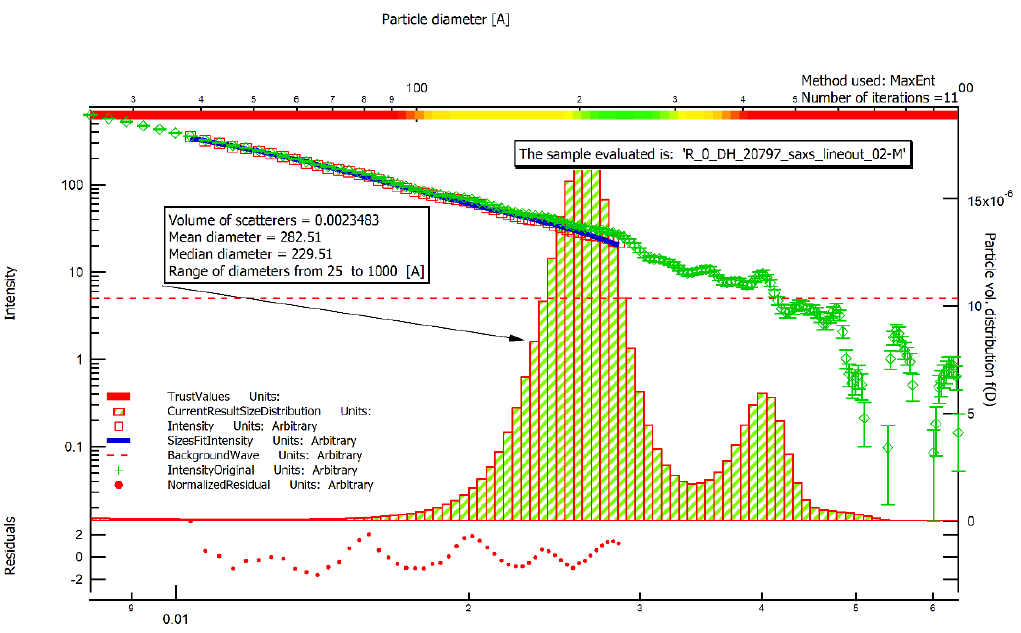
Figure 4. Estimation of the porosity in the milled-out specimen (DH) using SAXS line profile.